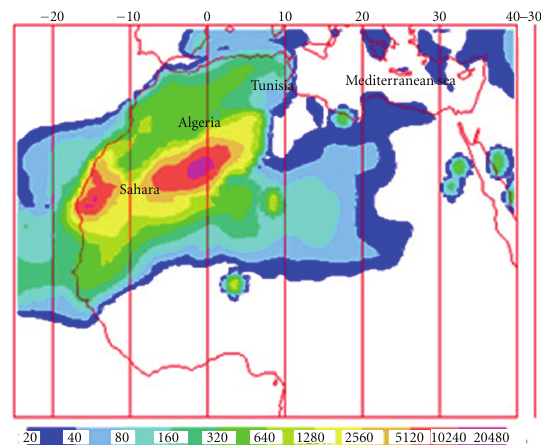
Figure 3: Evolution of the dust load from the NAAPS model (http://www.nrlmry.navy.mil/) during a sample of the Saharan events.